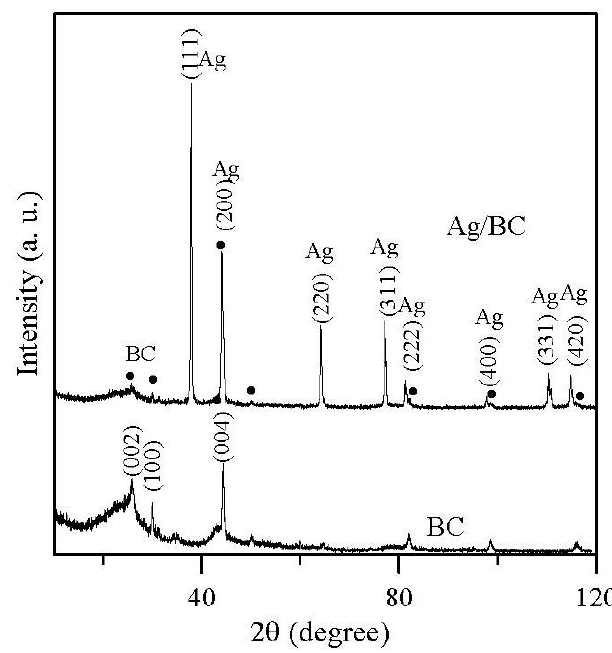
Figure 3. X-ray diffraction (XRD) pattern of Ag/BC and BC